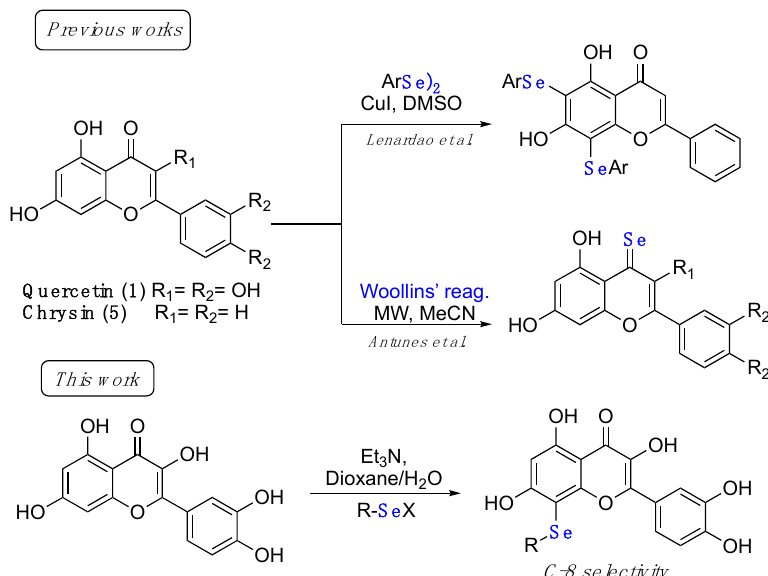
Figure 1. Examples of Se-functionalized flavonoids.